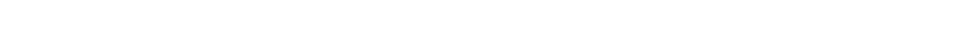
Frontiers in Endocrinology | Cancer